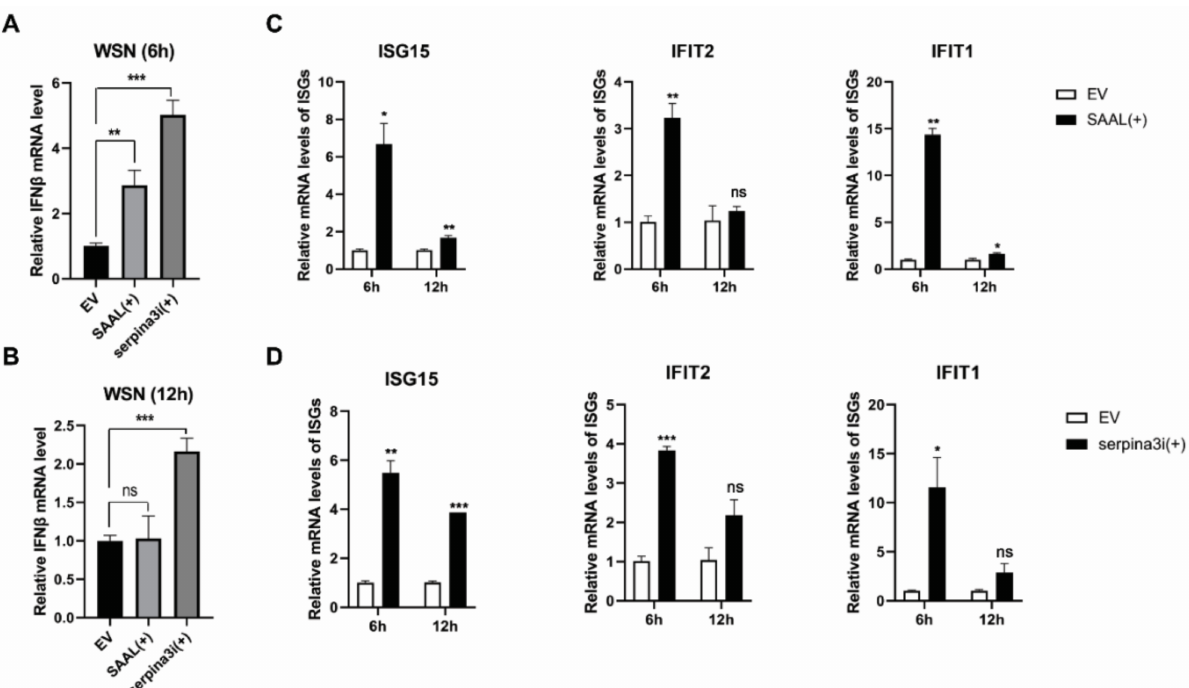
Figure 6. Overexpression of SAAL and Serpina3i in Mle-12 cells changes the expression of IFN- β and several critical ISGs. ( A ) SAAL and Serpina3i were transiently overexpressed in mle-12 cells, and the mRNA level of IFN- β was detected at 6 h post WSN infection. ( B ) SAAL and Serpina3i were transiently overexpressed in mle-12 cells, and the mRNA level of IFN- β was detected at 12 h post WSN infection. ( C ) The mRNA levels of several critical ISGs were detected after the overexpression of SAAL. ( D ) The mRNA levels of several critical ISGs were detected after the overexpression of Serpina3i. The means for three independent experiments ± SD are shown ( n = 3; means and SD; * p < 0.05, ** p < 0.01 *** p <